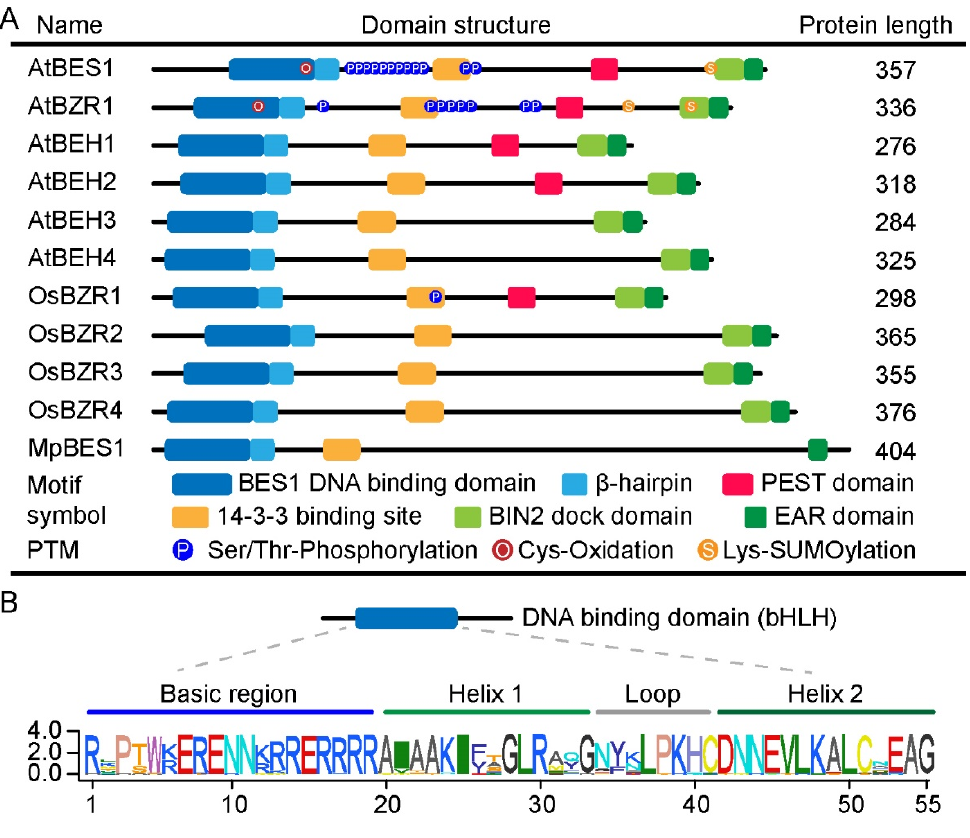
Figure 2. Conserved structural domains of BES1/BZR1 family proteins in Arabidopsis, rice, and Marchantia polymorpha . ( A ). The motif analysis was performed using MEME, and manual adjustments were carried out using the information from the literature. Motifs shown here include DNA binding domains and β -hairpins [58], 14-3-3 binding site [42,60], PEST domain [16,20,54], BIN2 docking domain [82], and EAR domain [83,84]. P shown in the diagrams represents the confirmed phosphorylation sites on serine or threonine residues [16,42,61,85], S represents SUMOylation on lysine residues [70,72] and O represents oxidation on cysteine residues [75]. ( B ). Consensus sequences of bHLH motifs in all the BES1 and BZR1 orthologs are shown in Figure 1. Multiple alignments were performed by Clustal Omega (Supplementary Figure S1). SeqLogo in TBtools [86] was used to analyze the conserved sequence.